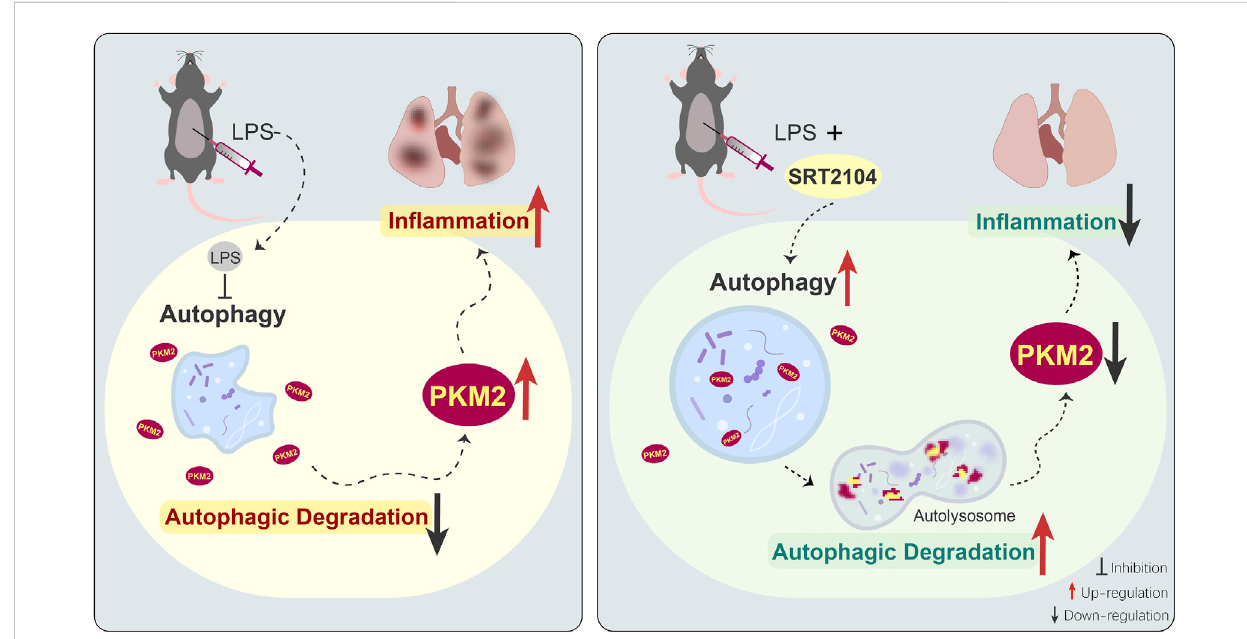
FIGURE 8 The schematic diagram of the mechanisms underlying the anti-in fl ammatory bene fi ts of SRT2104 in the present study. LPS exposure suppresses autophagy,whichresultsincompromisedautophagicdegradationofPKM2andthesubsequentupregulationofPKM2,ampli fi cationofin fl ammationand exacerbation of in fl ammatory injury. Administration of SRT2104 boosts autophagy, and then promotes the degradation of PKM2 and the alleviation of in fl ammatory